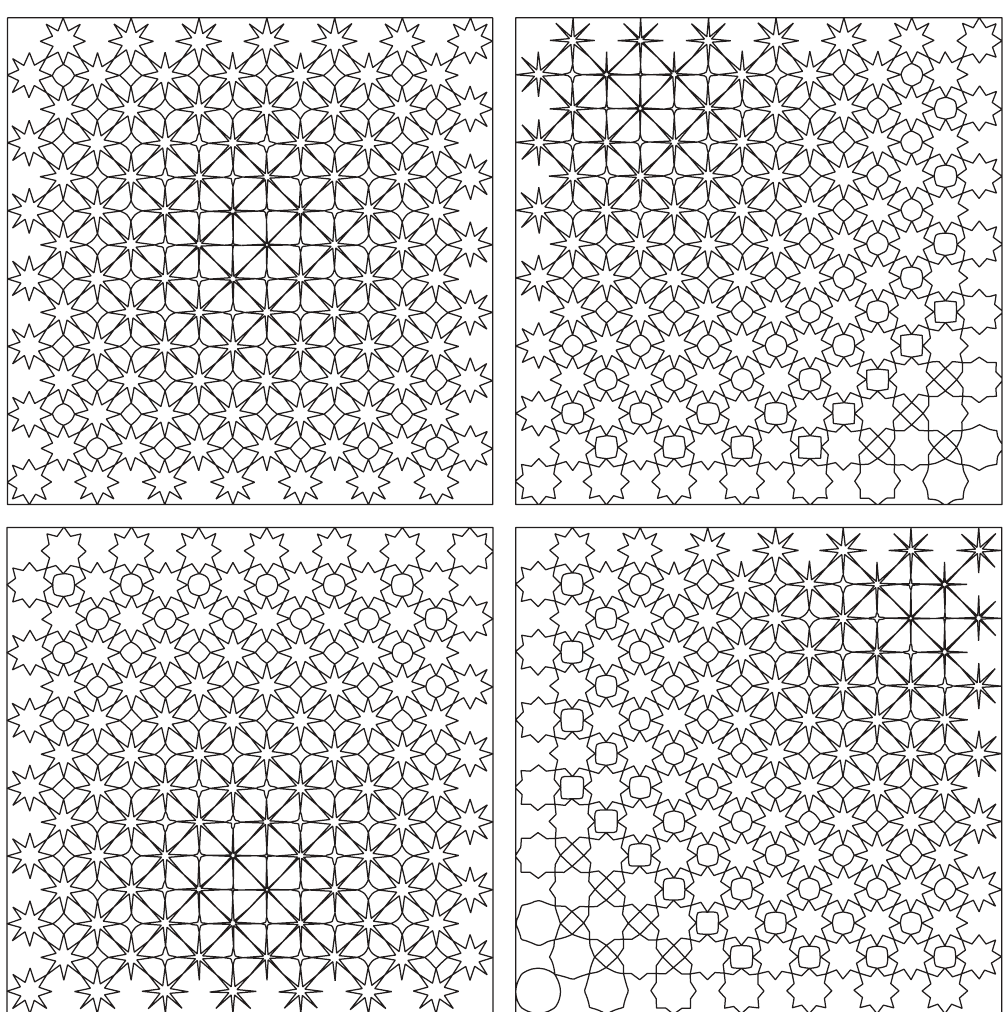
Figure 31: Pattern variations using Attractor